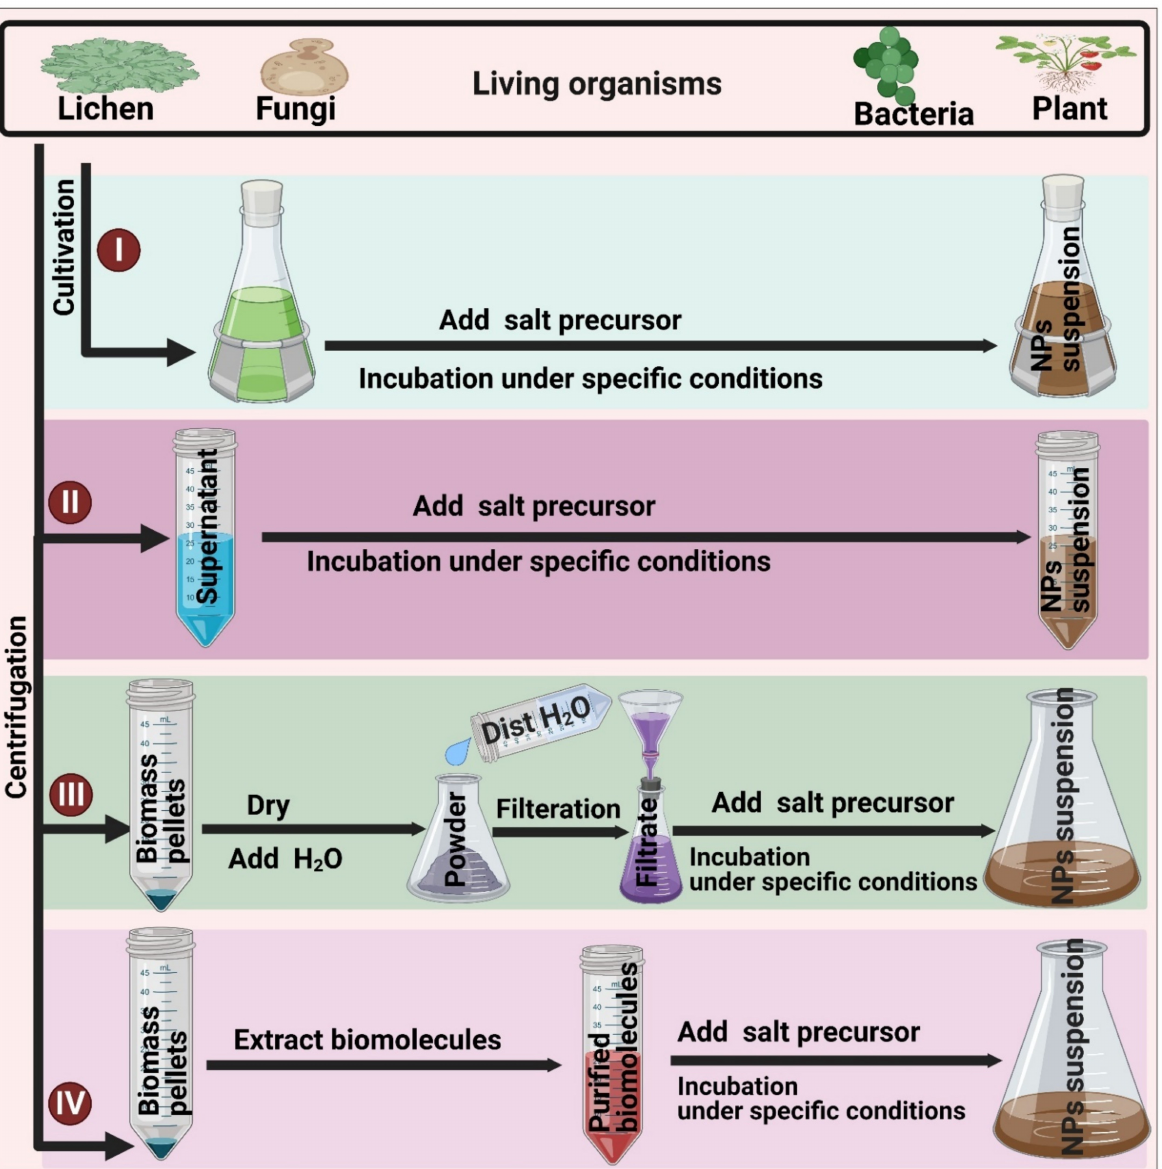
Figure 3. Green synthesis methods include intracellular synthesis route ( I ) and extracellular synthesis routes including cell-free, culture-medium-based synthesis of NPs ( II ), cell–biomass-filtrate synthesis of NPs ( III ), and biomolecule-mediated synthesis of NPs ( IV